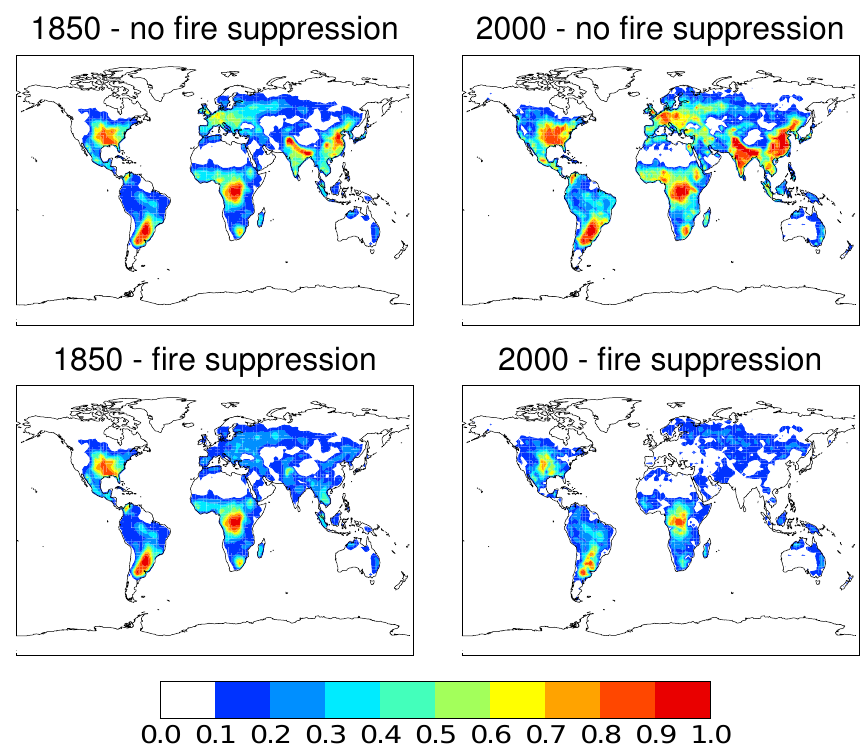
Fig. A2. Annual mean total ignition probability for the years 1850 and 2000 with and without fire suppression considered.